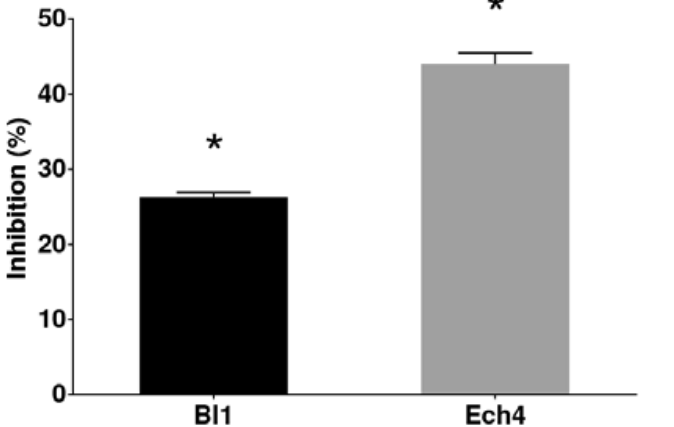
Figure 1. Recollected plants from the Andean Precordillera of Chile. E. chiloensis ( left ) and B. linearis ( right ).